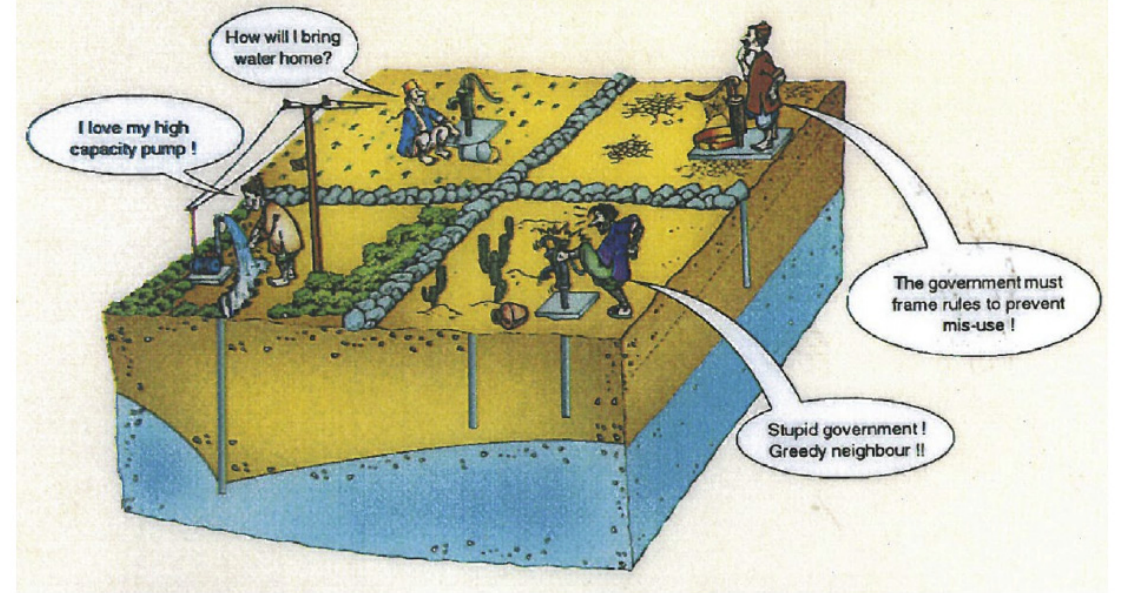
Figure 20. Misuse of modern pumps (adapted from